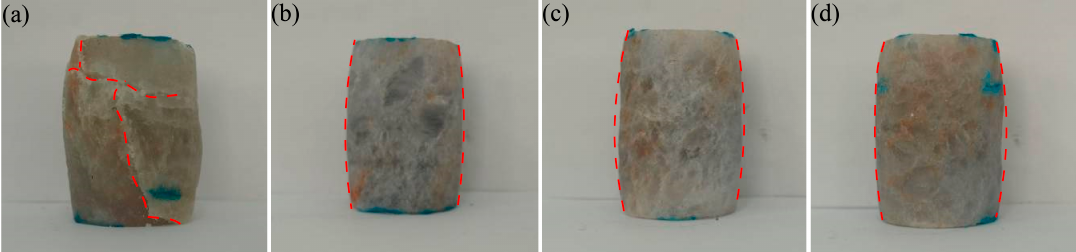
Figure 6. Pure salt rock after failure. ( a ) σ 3 = 5 MPa (SR-1); ( b ) σ 3 = 10 MPa (SR-5); ( c ) σ 3 = 15 MPa (SR-6); ( d ) σ 3 = 20 MPa (SR-7).